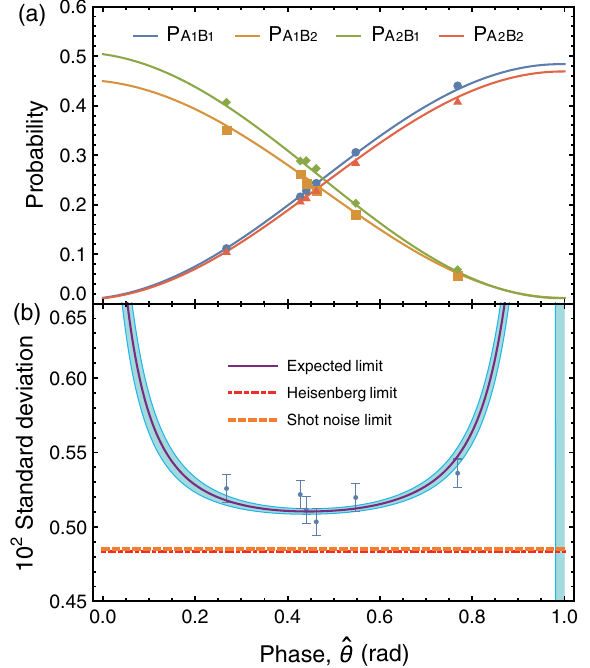
FIG. 3. Experimentally measured phase estimate of the random detection events and phase standard deviations for a distance of 10 km. (a) Experimental measurement of the random detection events, as shown by the markers. Lines represent the four probabilities from Appendix F. (b) Experimental phase standard deviation per trial of random detection events. Purple line: expected phase standard deviation calculated from the Fisher information from Appendix F. The shaded areas (blue bands) correspond to the 99.7% confidence regions, which are calculated from the uncertainty of the fit parameters. Orange dashed line: theoretical limit for SNL. Red dashed line: theoretical bound for HL. The error bars of the standard deviations are discussed in the main text.